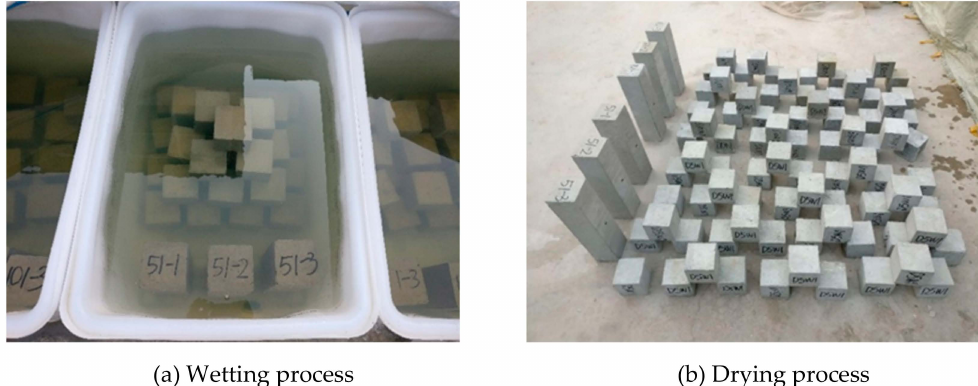
Figure 1. Concrete specimens exposed to sulfate solutions under drying–wetting cycles. ( a ) Wetting process; ( b ) drying